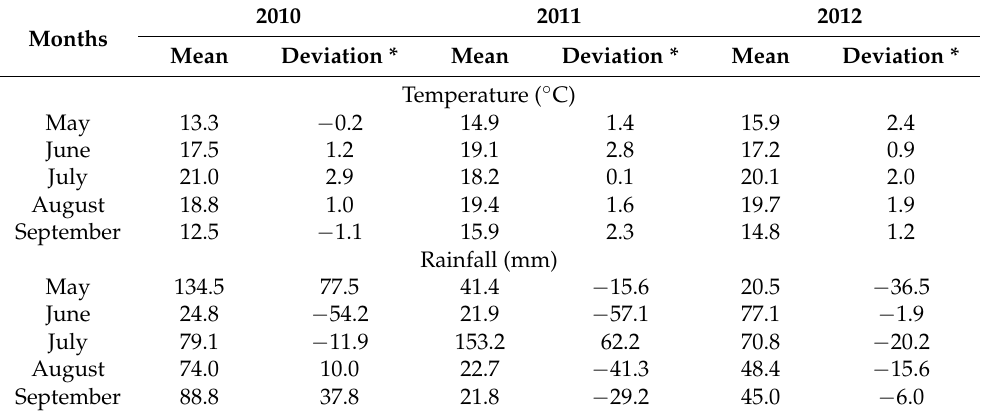
Table 1. Mean air temperature and sum of rainfall during the eggplant growing period in